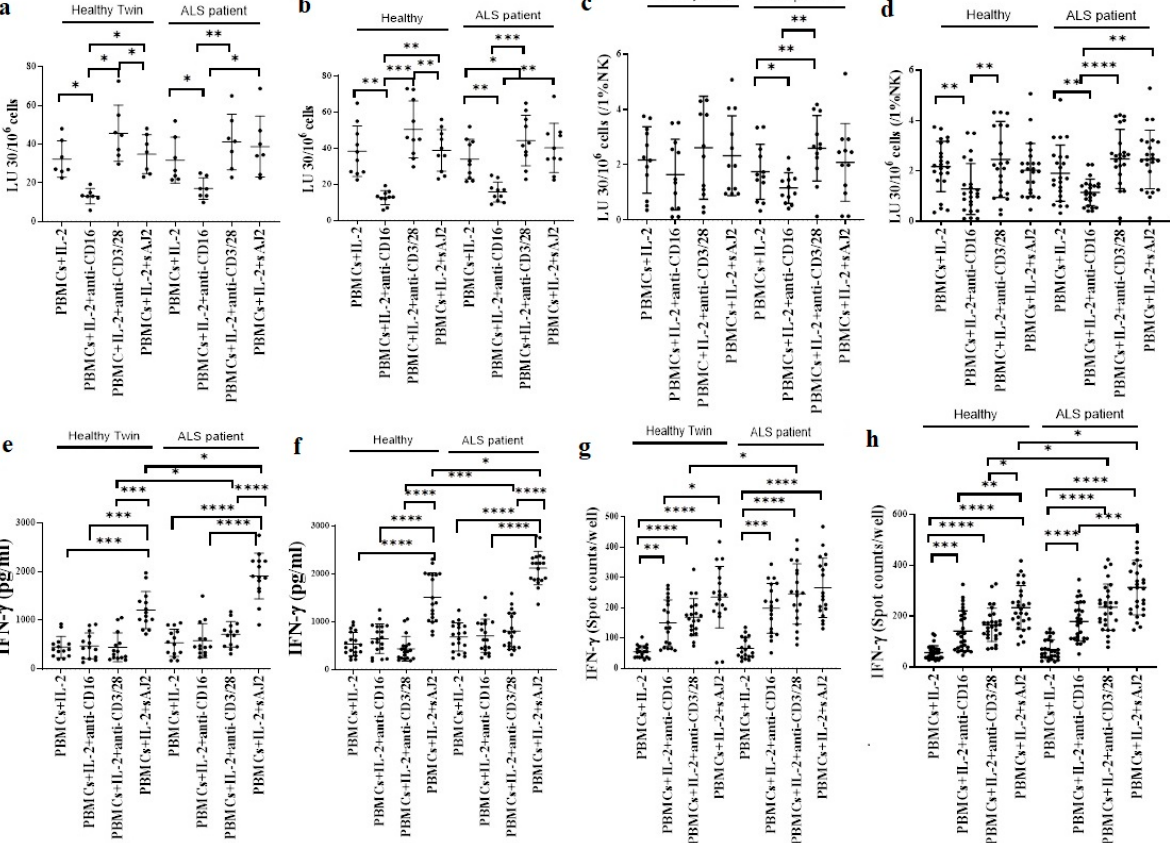
Figure 1. Significant increased IFN- γ secretion but not NK cell-mediated cytotoxicity was seen in PBMCs of ALS patients. PBMCs of healthy individuals and ALS patients were isolated from peripheral blood as described in Section 2. PBMCs were treated with IL-2 (1000 U/mL) or with a combination of IL-2 (1000 U/mL) and anti-CD16 mAbs (3 µ g/mL) or IL-2 (1000 U/mL) and anti- CD3/28 antibody (25 µ L/mL) or IL-2 (1000 U/mL) and sAJ2 (PBMC:sAJ2, 1:20) for 18 h before they were used in standard 4 h 51 Cr release cytotoxicity assay against OSCSCs. The lytic units (LU) 30/10 6 cells were determined using the inverse number of PBMCs required to lyse 30% of OSCSCs × 100 (( a ) ( n = 7), ( b ) ( n = 10)). LUs of Figure 1a (( c ) ( n = 12)) and Figure 1b (( d ) ( n = 23)) were used to determine LUs per 1% NK cells using percentages of CD16+ cells in PBMCs obtained by flow cytometric analysis. PBMCs were treated as described in Figure 1a, 18–20 h after treatments, the supernatants were harvested to determine IFN- γ secretion using single ELISA (( e ) ( n = 14), ( f ) ( n = 18)). PBMCs were treated as described in Figure 1a, 18–20 h after treatments, the number of cells secreting IFN- γ were determined as spot counts using ELISpot assay (( g ) ( n = 19, ( h ( n = 28)). **** ( p -value < 0.0001), *** ( p -value 0.0001–0.001), ** ( p -value 0.001–0.01), * ( p -value